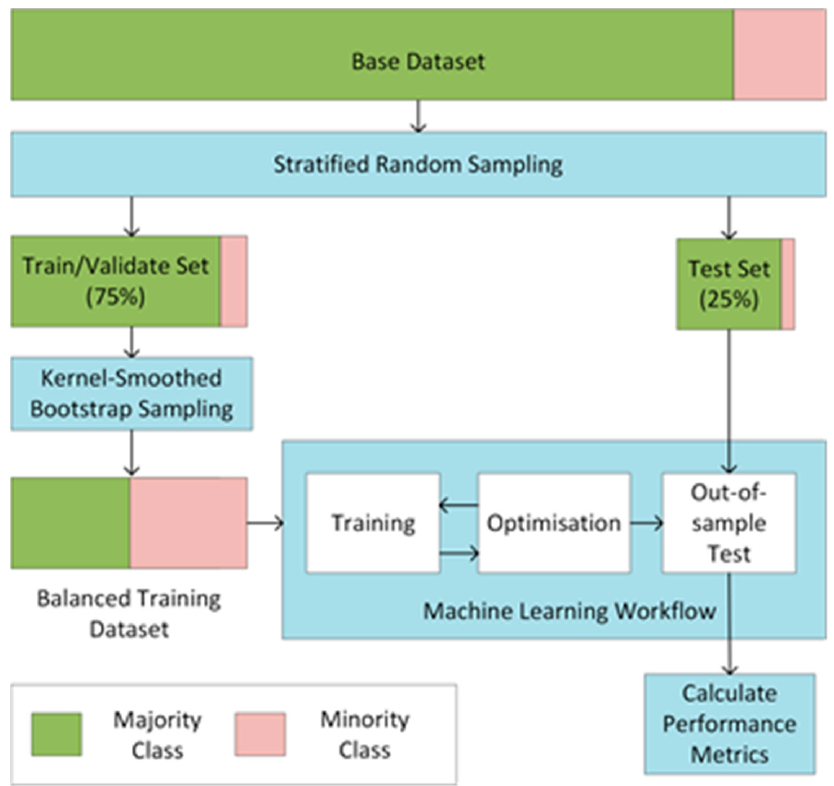
Figure 1. The outline for the machine learning workflow adopted demonstrating the data partitioning and minority class re-sampling process. The blue areas denote processes in the workflow. The Kernel-Smoothed bootstrap sampling was performed after the testing set was partitioned from the train/validate set to ensure a complete out-of-sample test.